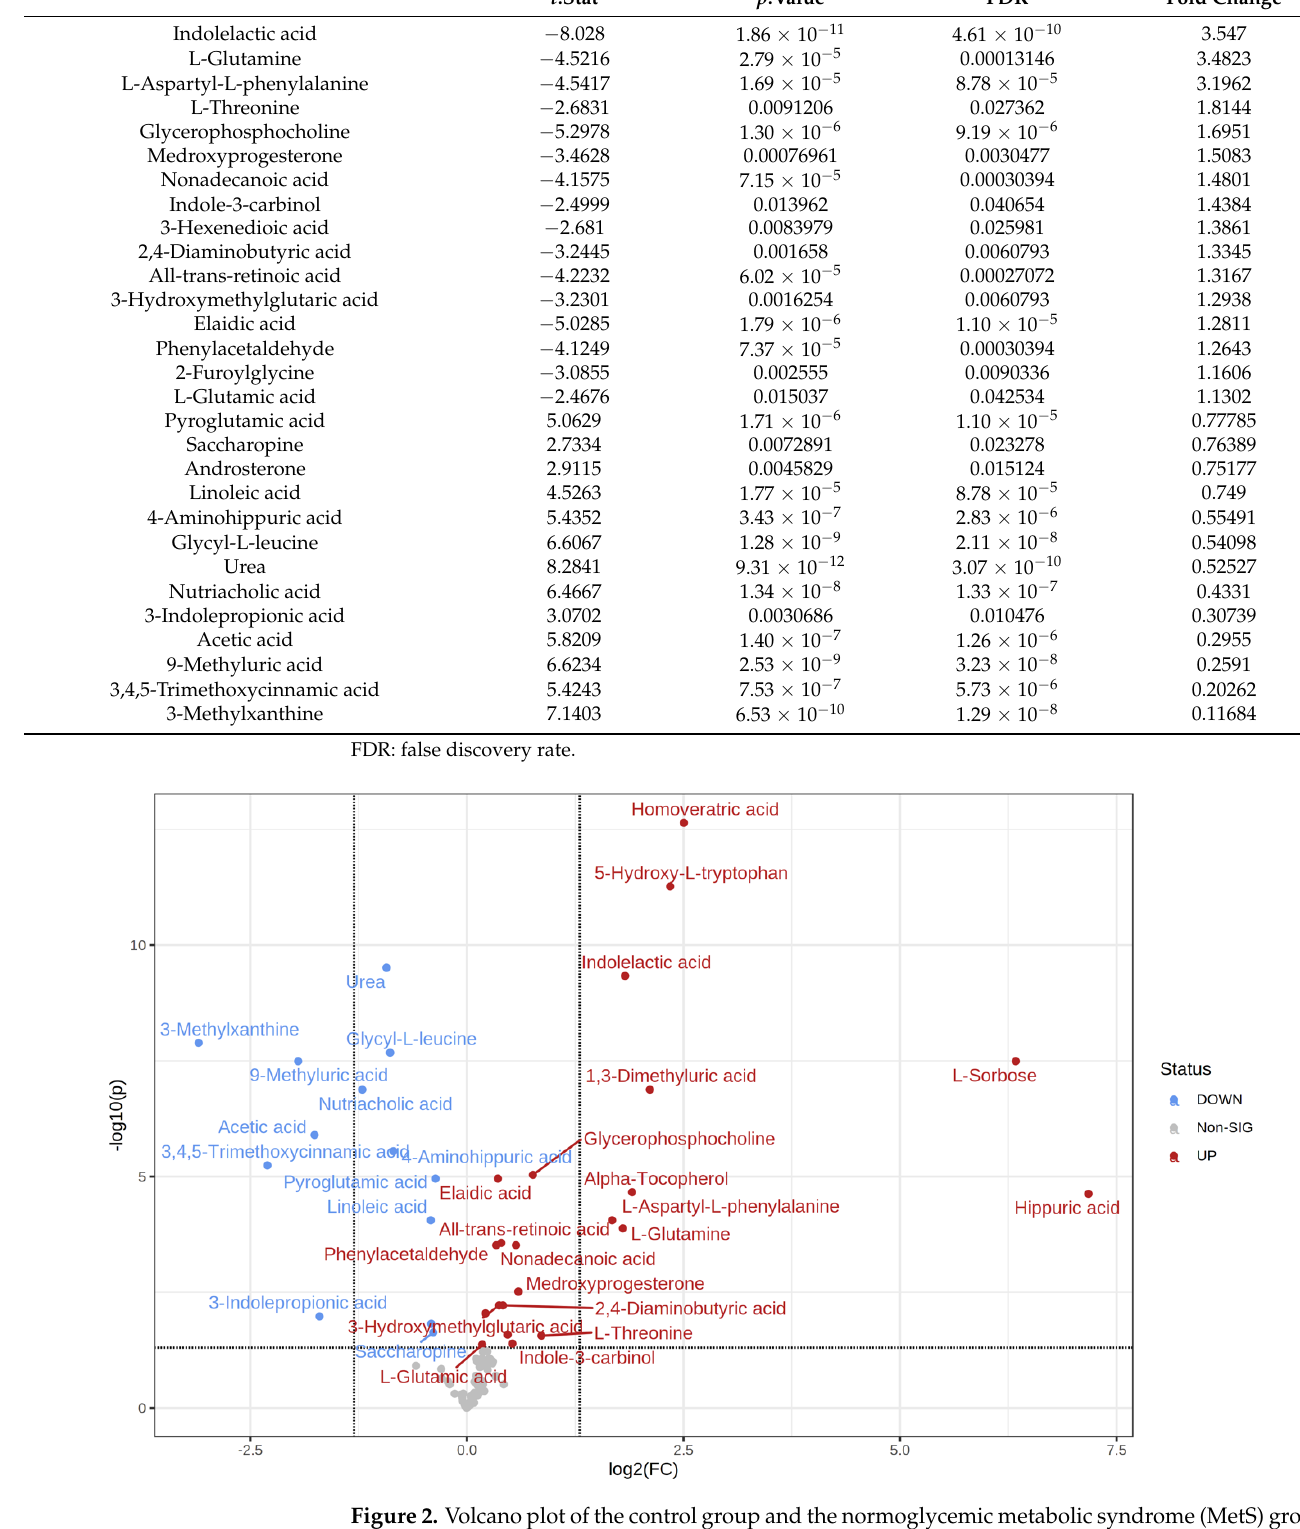
Figure 2. Volcano plot of the control group and the normoglycemic metabolic syndrome (MetS) group. T -test analysis identified 57 significantly different metabolites between the control and prediabetic MetS groups (39 upregulated vs. 18 downregulated) (Table 3). Specifically, hippurate, L-sorbose, 5-hydroxy L-tryptophan, and homoveratric acid were highly upregulated in the prediabetic MetS group compared to those in the control group (Figure 3). In contrast, 3-methylxanthine, 9-methyluric, 3,4,5- trimethoxycinnamic acid, and 3-in- dolepropionic acid were highly downregulated in the prediabetic MetS group compared to those in the control group (Figure 3). Table 3. Statically significant metabolites among the prediabetic MetS group and the controls. t .Stat